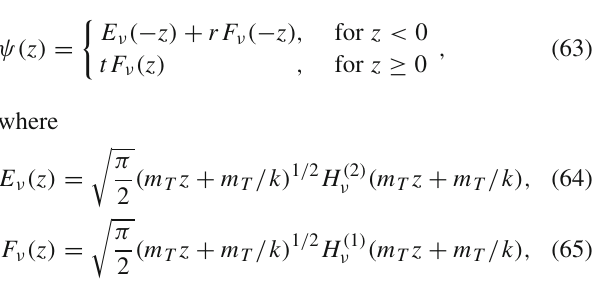
Fig. 2 Transmission coefficient for KR field in Randall–Sundrum delta like scenario with k = 1 as function of E = m 2 Horndeski tensor coupling, b Riemann tensor coupling